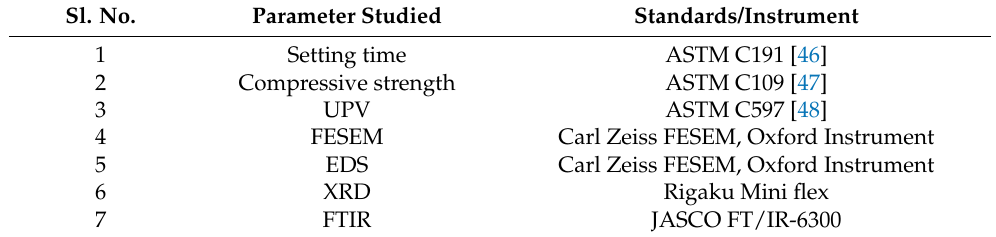
Table 4. Experimental Program.